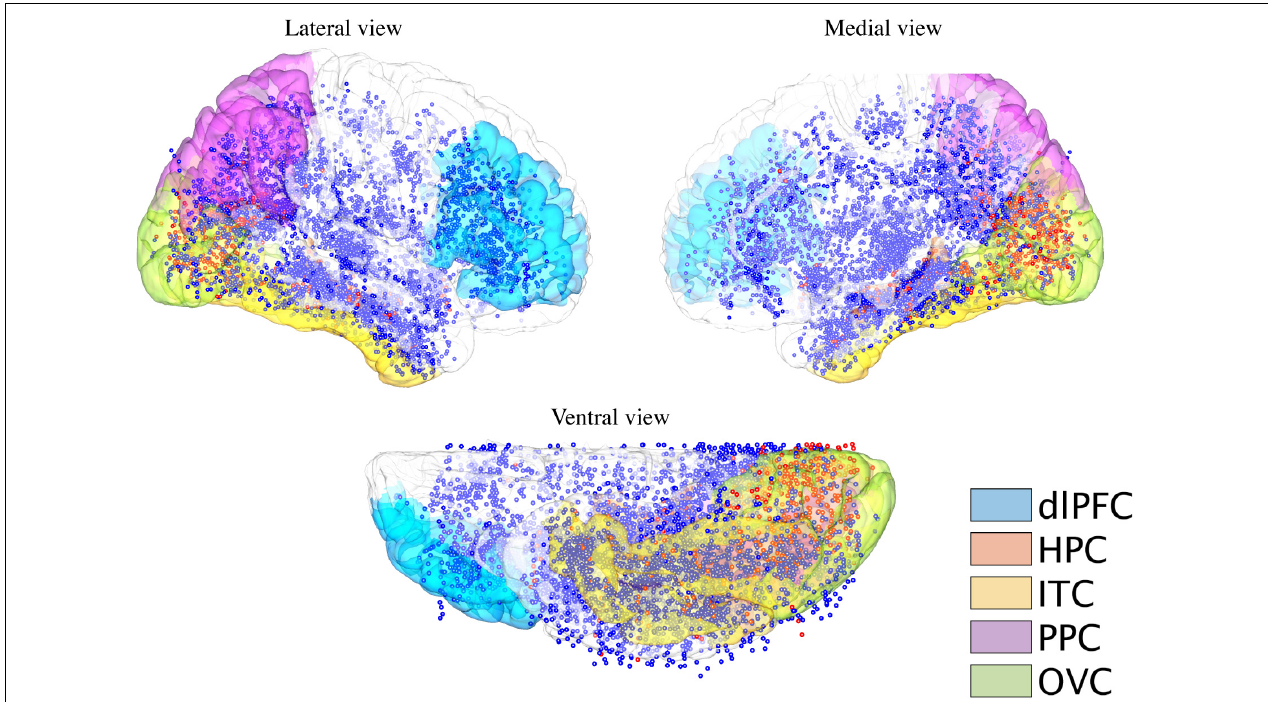
FIGURE 1 | Cortical distribution of electrodes receiving intracranial electric stimulation. Electrodes were stimulated during the functional mapping sessions over all the patients ( n = 40 patients) pooled on the MNI152 brain surface. Blue dots indicate stimulated electrodes, which elicit no visual responses, while red dots indicate stimulated electrodes, which elicit either internal or external visual responses for at least one patient. The structural modules are rendered on the brain’s surface with different colors. dlPFC, dorsal lateral prefrontal cortex; HPC, hippocampus; ITC, inferior temporal cortex; PPC, posterior parietal cortex; and OVC, occipital visual